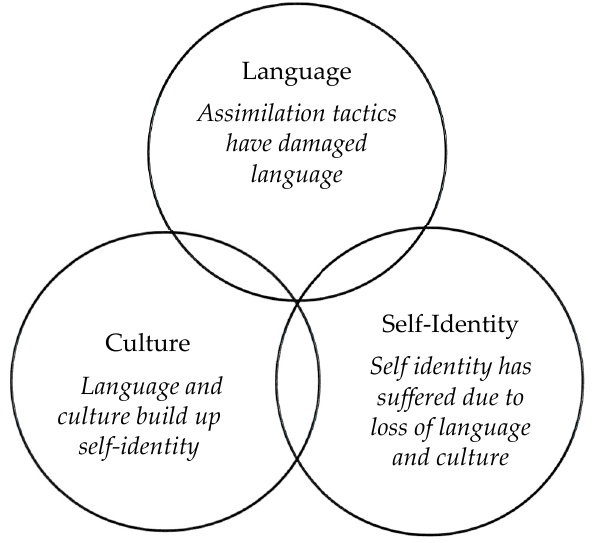
Figure 1. Interconnection of language, culture, and self-identity.